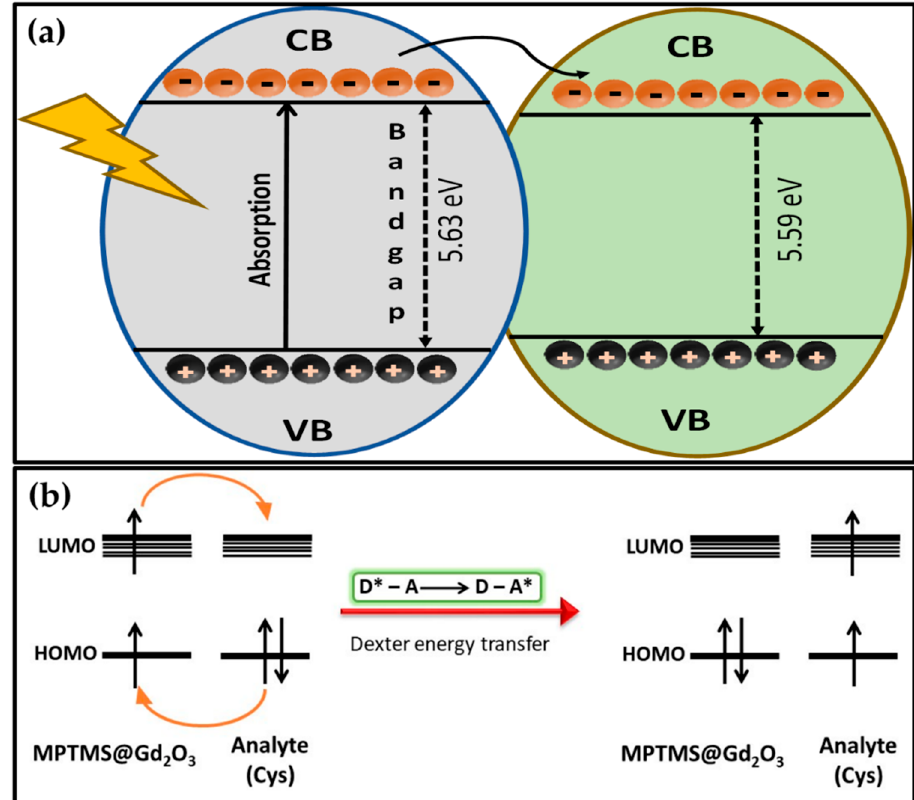
Figure 6. ( a ) The proposed mechanism of Cys quenching through PET energy transfer and ( b ) Dex- ter energy transfer between MPTMS@Gd 2 O 3 nanoparticles and Cys molecules. energy transfer between MPTMS@Gd 2 O 3 nanoparticles and Cys